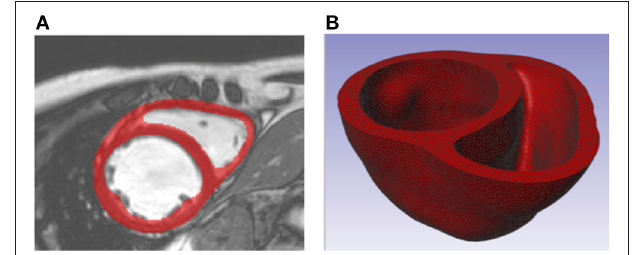
FIGURE 1 | (A) Short axis MR image of patient with dilated chronic heart failure overlaid with the segmentation of the myocardium. (B) Truncated biventricular geometry extracted from segmentation and meshed using tetrahedral